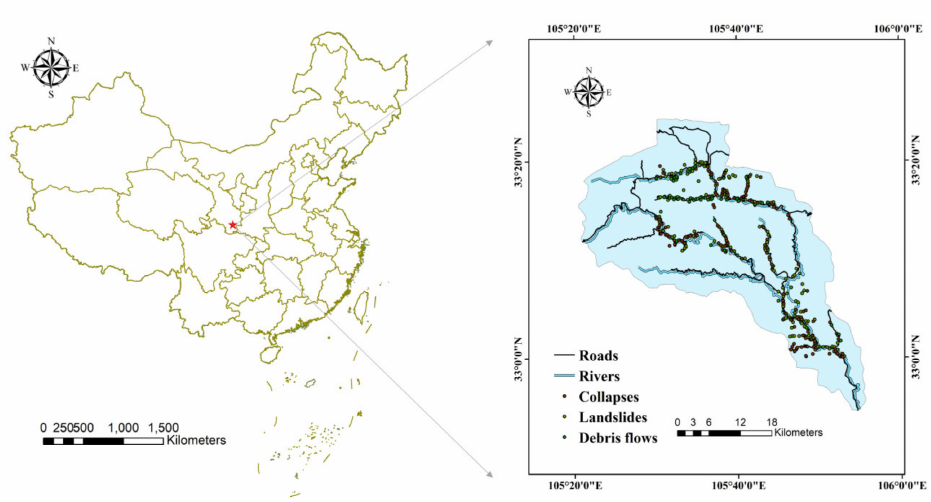
Figure 1. Location of the Yanzi River Basin and the geological hazard distribution map (Source: Dataset of the 2015 Geo-Hazard Survey of the Yanzi River Basin, Upstream of the Jialing